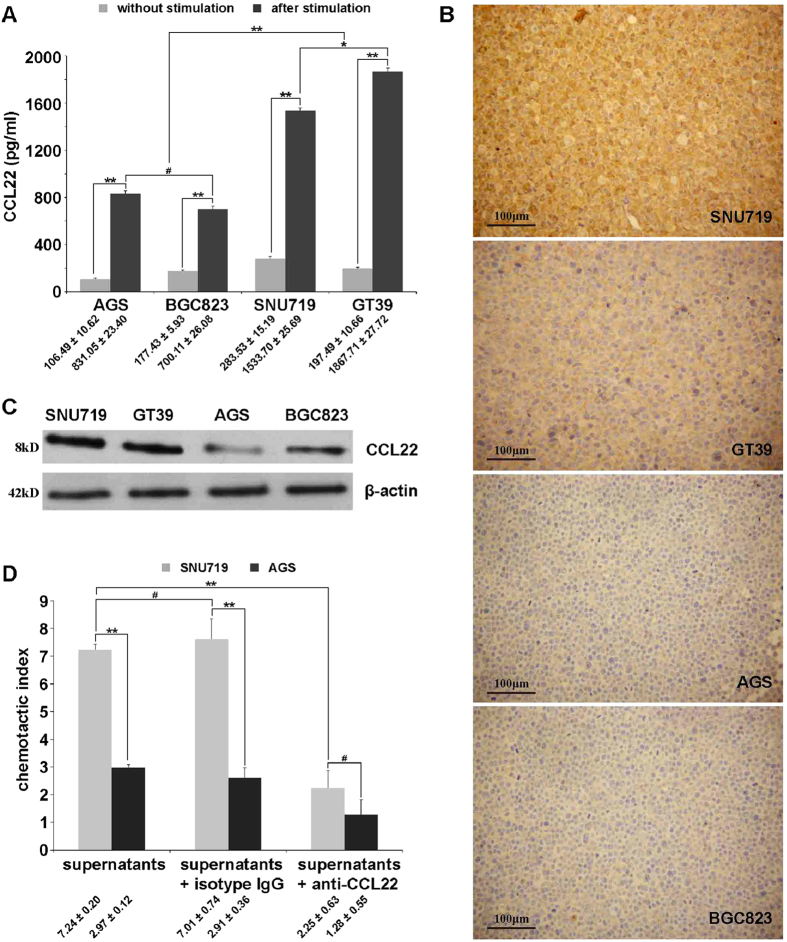
CCL22 production in gastric cells and its chemotactic effect in Treg migration.(A) Quantification of CCL22 levels within gastric cell supernatants with or without PBMC stimulation, assayed by ELISA. All of the gastric cells demonstrated a remarkable increase in CCL22 secretion after PBMC stimulation, especially EBV (+) SNU719 and GT39 gastric cells. (B) Immunohistochemical staining of CCL22 revealed stronger expression in EBV (+) SNU719 and GT39 gastric cells than in EBV (−) AGS and BGC823 gastric cells after stimulation by PBMCs. (C) Western blot analysis showed that the level of CCL22 protein was higher in EBV (+) SNU719 and GT39 gastric cells than that in EBV (−) AGS and BGC823 gastric cells after being stimulated by PBMCs. (D) After the gastric cells were stimulated by PBMCs, Treg transmigration toward EBV (+) SNU719 gastric cell supernatants was higher than that toward EBV (−) AGS gastric cell supernatants and were specifically blocked by anti-CCL22 antibody but not by isotype IgG. Error bars represent the mean ± SD, n = 3. #p > 0.05; *p < 0.05; **p < 0.01. All p values were from one-way ANOVA.